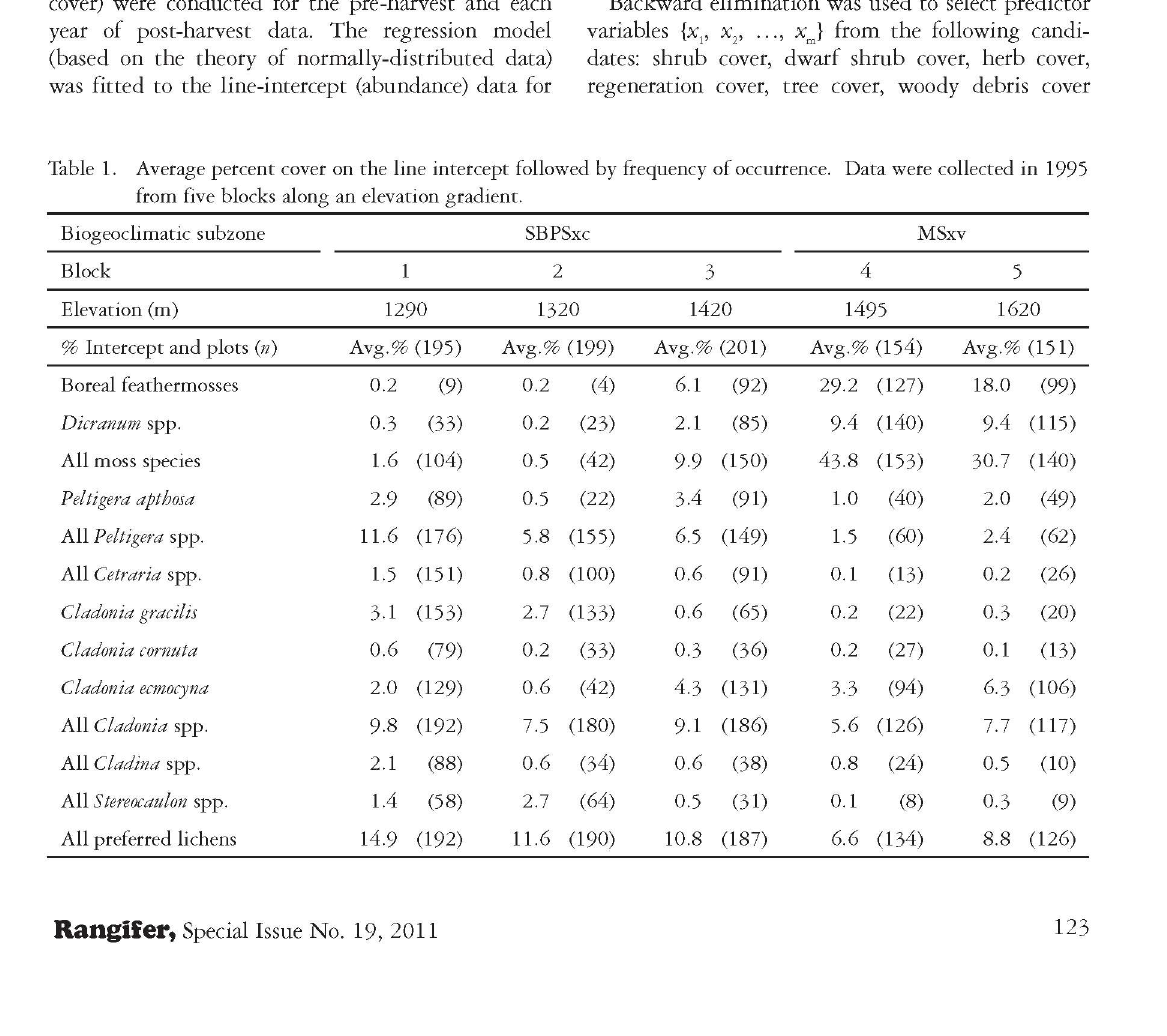
Table 1. Average percent cover on the line intercept followed by frequency of occurrence. Data were collected in 1995 from five blocks along an elevation